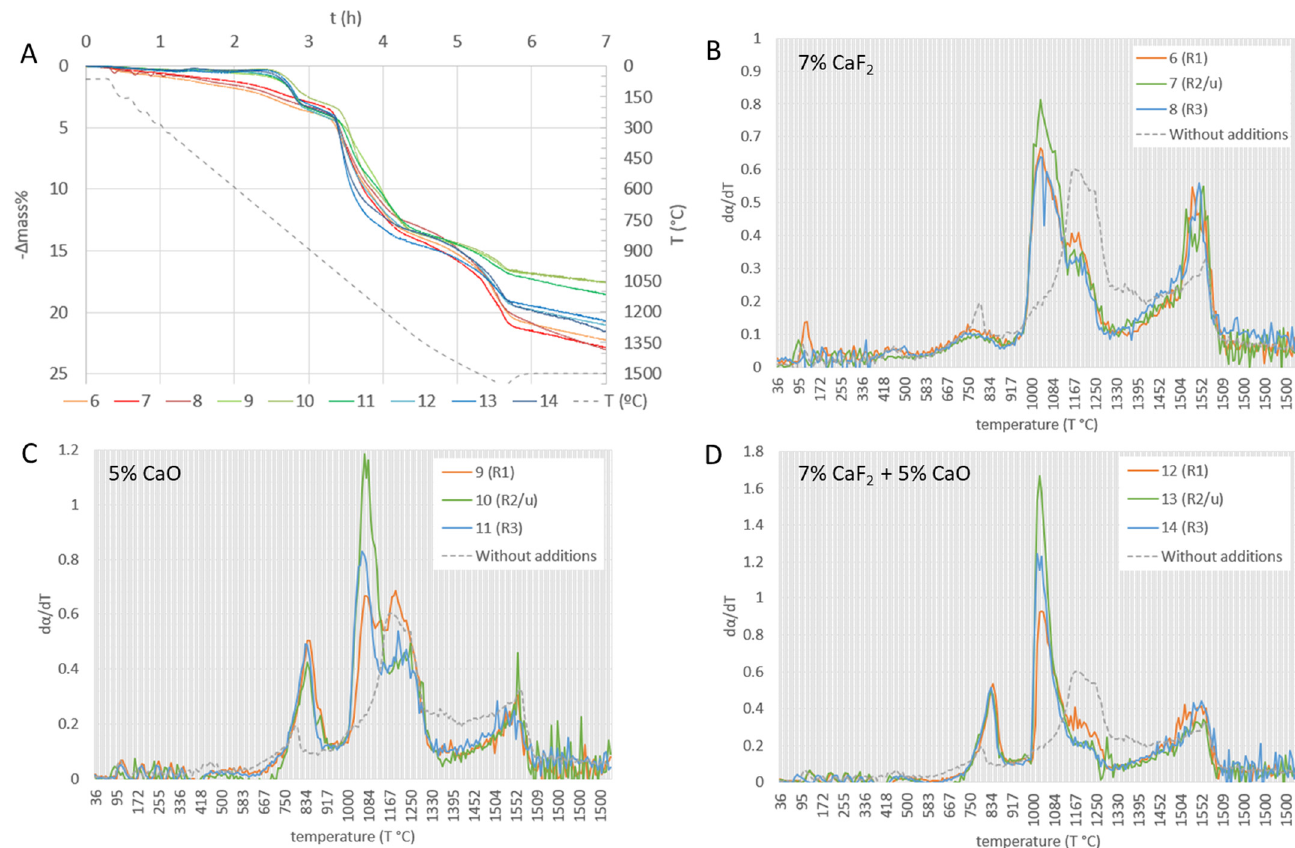
Figure 5. ( A ) Mass-loss curves for experiments 6–14, with all conducted using the same temperature program up to 1500 °C for R1, R2/u, and R3 concentrates. ( B – D ) Derivative conversion curves for experiments 6–8 (with 7% CaF 2 ), 9–11 (with 5% CaO), and 12–14 (with 7% CaF 2 + 5% CaO). Conversion rates for R2/l concentrate without additions shown as a reference [9].